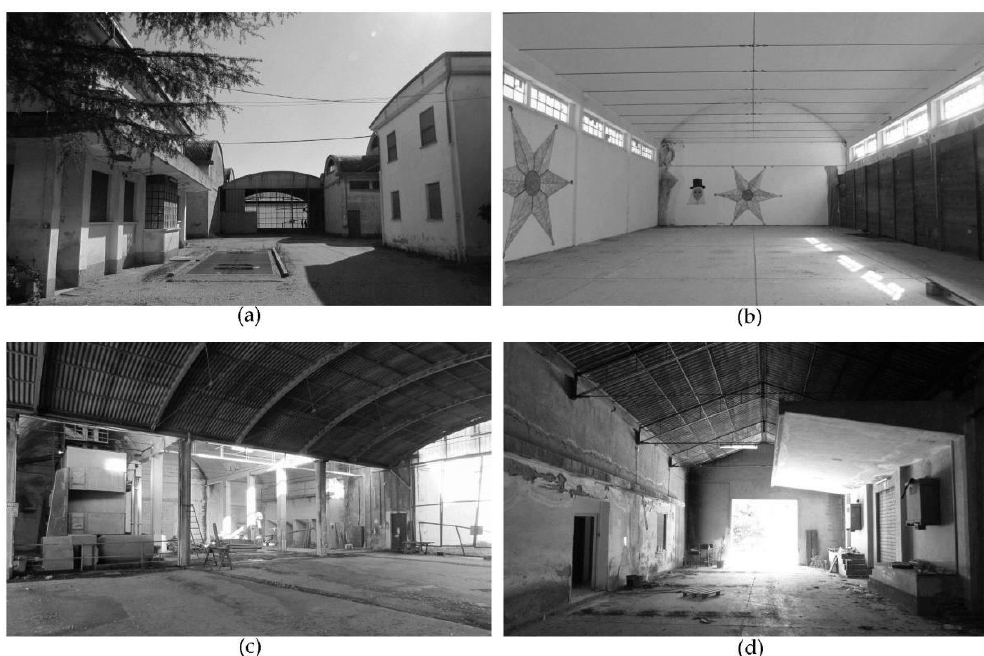
Figure 5. Distribution space among warehouse, office buildings, and gatehouse ( a ); natural lighting system in the rice processing warehouses ( b ); shed added in 1971 and its rounded vaulted ceiling and the background the main storage warehouse ( c ); new warehouse added in 1971 ( d ).